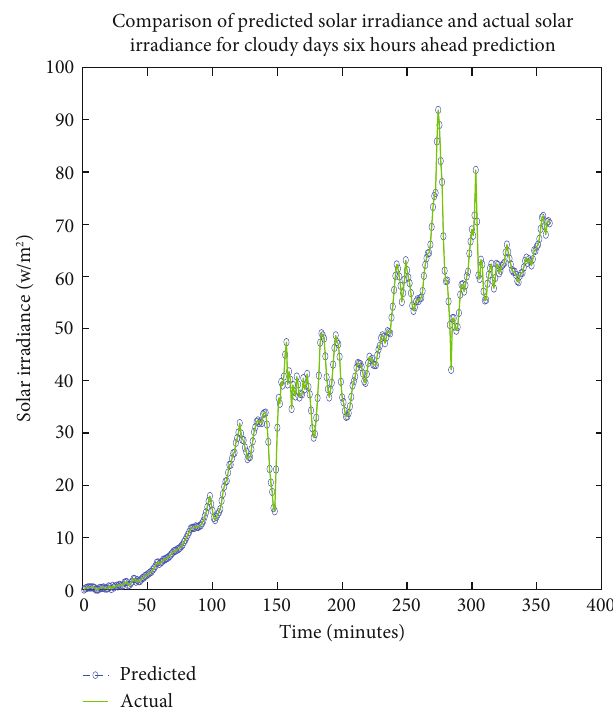
Figure 37: Comparison of predicted solar irradiance and actual solar irradiance for cloudy day six-hour-ahead